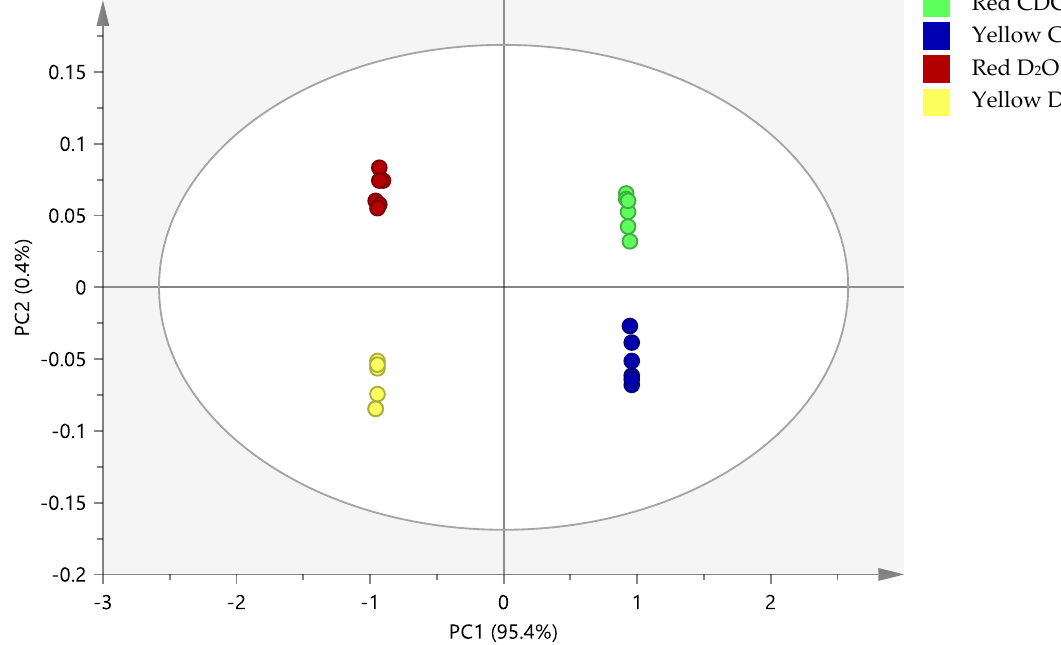
Figure 4. The orthogonal partial least squares discriminant analysis (OPLS-DA) score plot of the 1 H-NMR data representing red and yellow watermelon cultivars in two different solvents (D 2 O and CDCl 3 ); R2X = 0.995, Q2X = 0.862, n = 6.